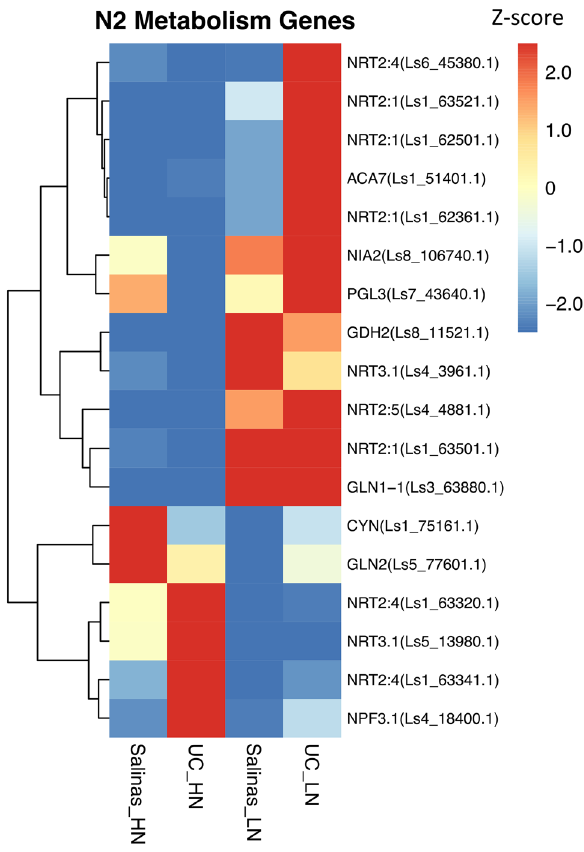
Figure 6. Differential expression of nitrogen metabolism genes Salinas and UC genotypes when grown at high nitrogen (HN) and low nitrogen (LN)